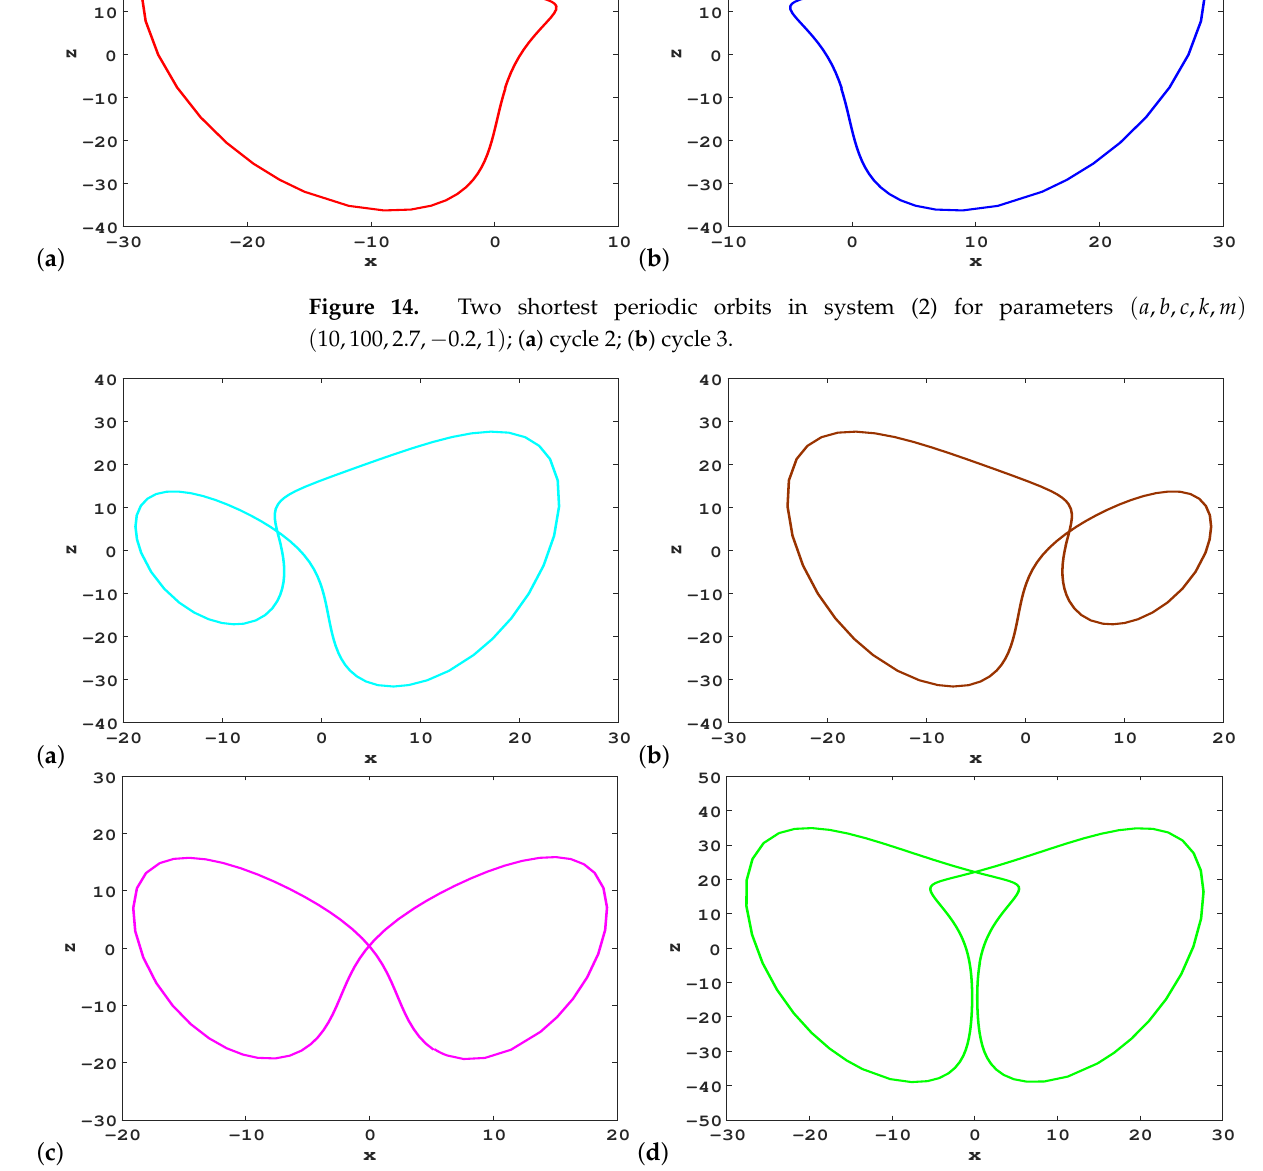
Figure 15. Four periodic orbits with topological length 2 in system (2) for parameters ( a , b , c , k , m ) = ( 10,100,2.7, − 0.2,1 ) ; ( a ) cycle 03; ( b ) 12; ( c ) 01; ( d )